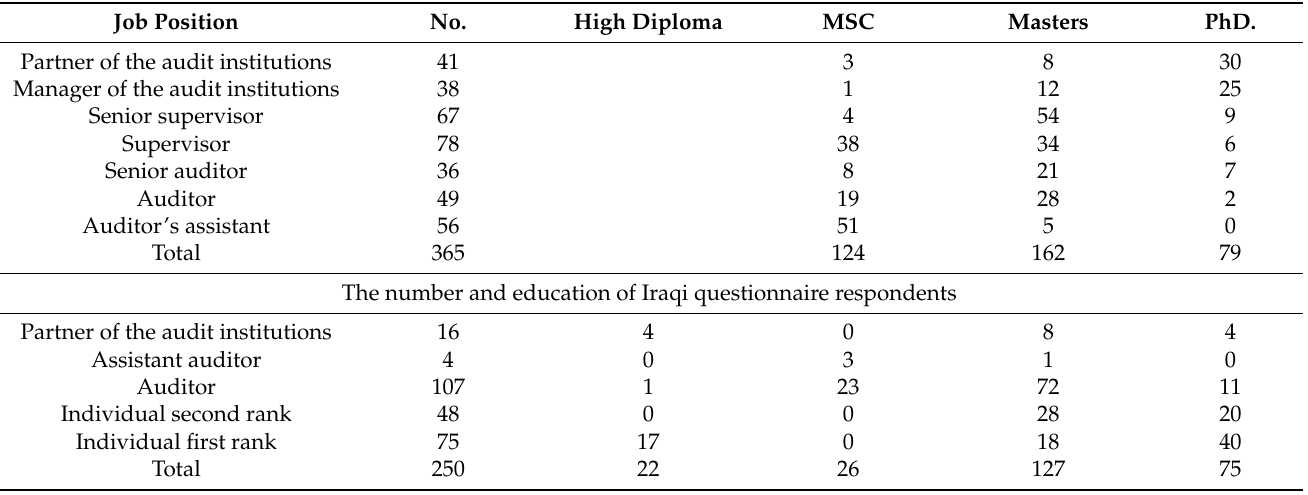
Table 1. The number and education of Iranian questionnaire